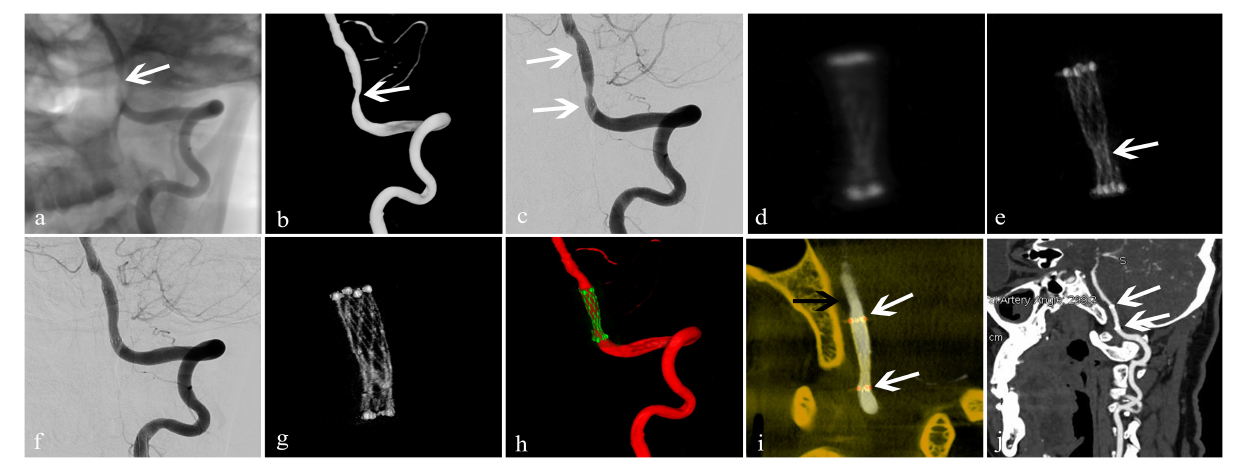
FIGURE 5 | Treatment of an arteriosclerotic stenosis of the V4 segment of the left vertebral artery using the NeuroformTM EZ stent. A 67-year-old man presented with dizziness and instability while standing of 6-day duration. (a,b) 2D and 3D-DSA showed 78% stenosis of the V4 segment of the left vertebral artery (white arrow); (c) dilation using a GatewayTM balloon was done followed by insertion of a Neuroform EZ stent measuring 3.0 mm × 15 mm (white arrow) with 50% residual stenosis; (d) conventional FDCT showed full expansion of the proximal and distal stent markers but poor visualization of the stent itself with an image-quality score of 0; (e) HD-FDCT showed the stent was partially expanded with an image-quality score of 1 (white arrow); (f) angioplasty with a Gateway balloon was undertaken again with a 3.0 mm × 9 mm balloon to treat stent under-expansion. Review by 2D-DSA showed that stenosis was improved significantly (residual stenosis = 11%); (g) after balloon angioplasty, HD-FDCT was done again and confirmed that the stent was fully expanded; (h,i) Dual-volume 3D fusion images showed good apposition of the stent to the vessel wall (stent, white arrow; vessel wall, black arrow); (j) 6-month follow-up CTA showed durable stent patency (white